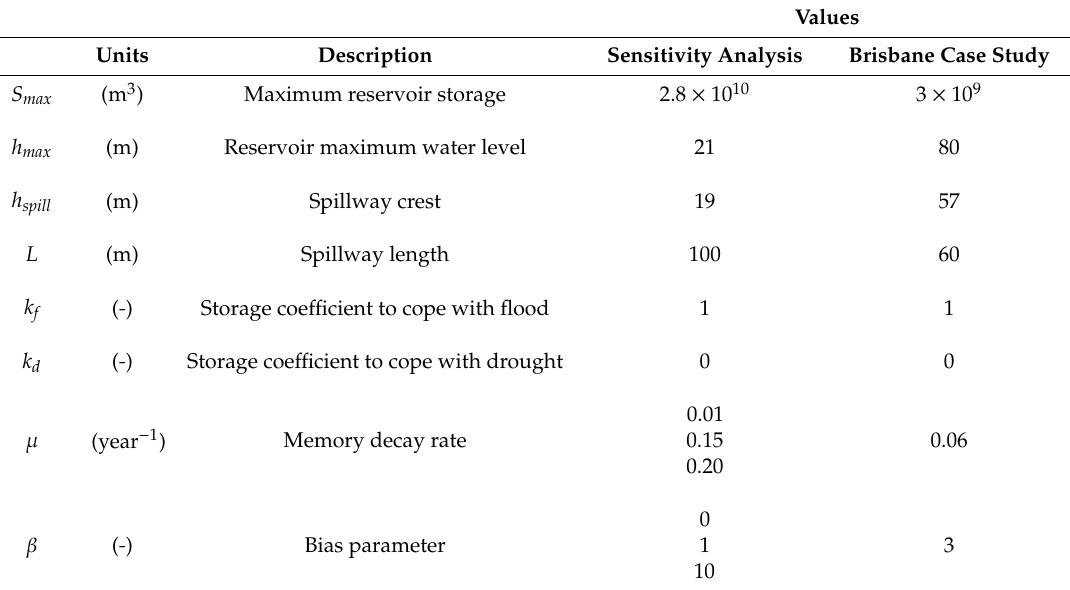
Table 2. Time-invariant parameters of the reservoir management module and values used in the sensitivity analysis and the Brisbane case